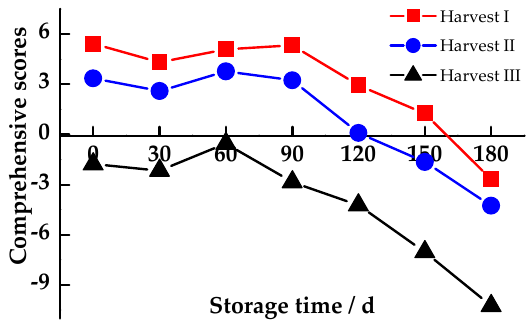
Figure 5. Comprehensive scores of the postharvest antioxidant capacity for Majiayou pomelo (MP) at di ff erent harvesting periods during storage at ambient temperature.